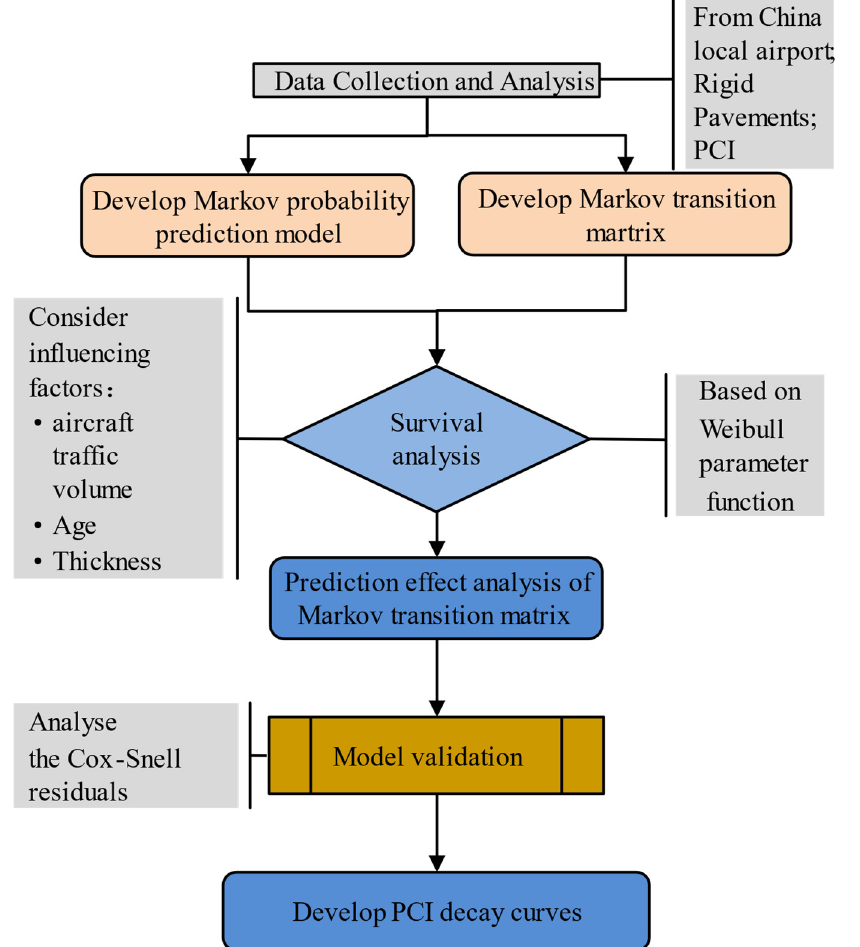
Figure 1. Research